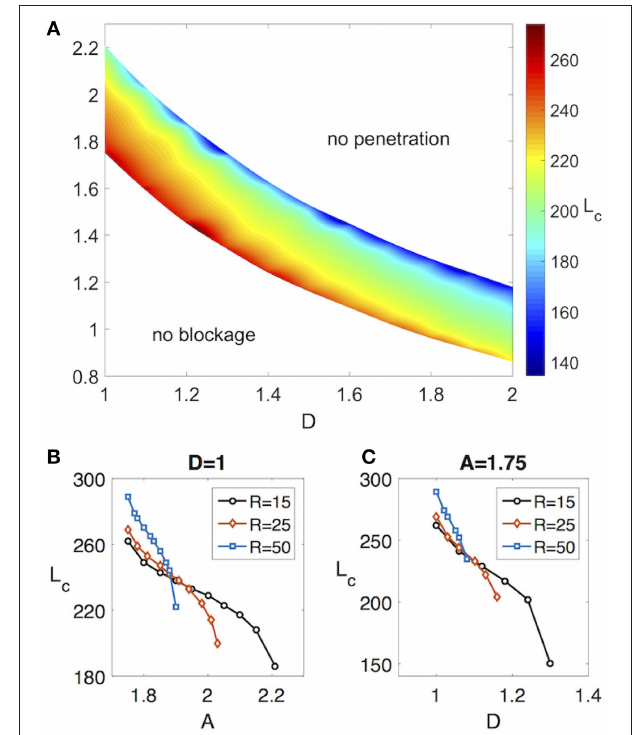
FIGURE 5 | (A) The phase diagram shows the regions of non-penetration, non-blockage, and rotor initiation due to the FPR with critical length L c for different values of D and A but fixed R 15. (B) The detailed dependence of = L c on A for fixed D 1 and different R . (C) The detailed dependence of L c on = D for fixed A 2 and different R =